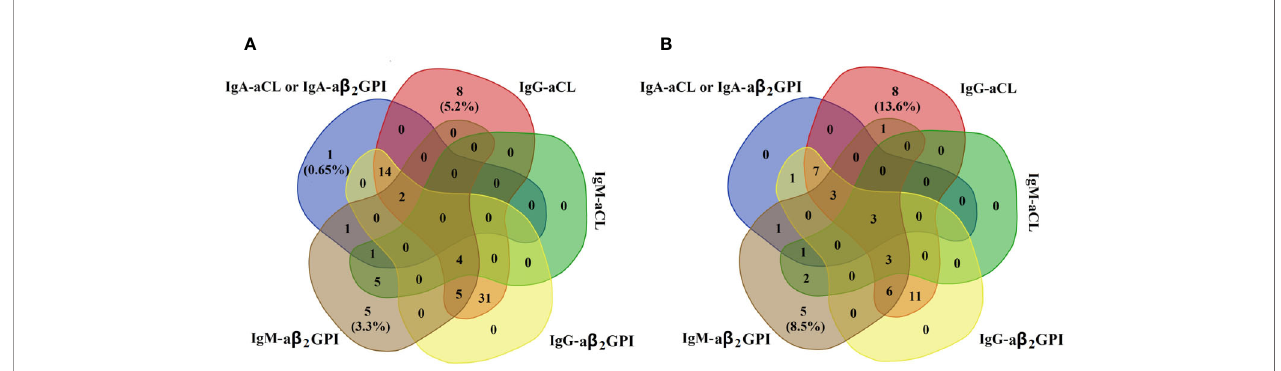
FIGURE 2 | Distribution of IgA – aPL (either IgA – aCL or IgA – a b 2 GP Ⅰ was positive), IgG – aCL, IgM – aCL, IgG – a b 2 GP Ⅰ , and IgM – a b 2GP Ⅰ in the (A) PAPS group (n = 153) and (B) SAPS (n =